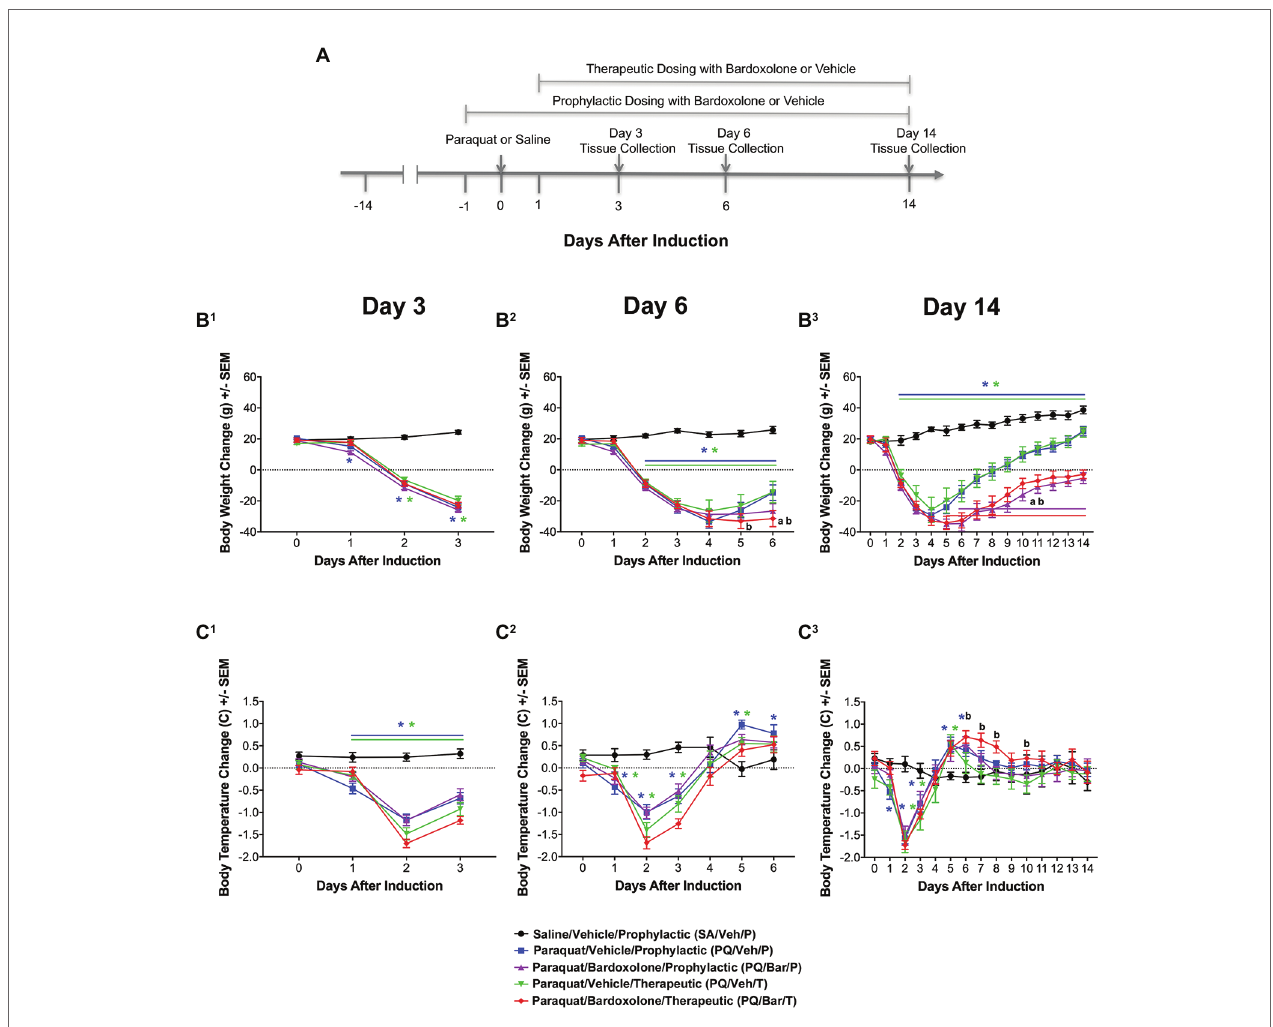
FIGURE 1 | Standard in-life measurements confirmed lung injury and detected effects of bardoxolone treatment in a rodent model of paraquat (PQ)-induced lung injury (PQiLI). (A) Experimental timeline. After a 14-day acclimation period, rats were given an intra-tracheal dose of PQ on Day 0. Rats were orally treated with bardoxolone or vehicle either prophylactically starting the day before PQ administration (Day 1) or therapeutically starting the day after PQ administration (Day 1) daily until study end. Treatment schedules are shown in brackets. Three separate subgroups of rats per study group were euthanized on either Days 3, 6, or 14 for endpoint tissue collection. Automated breathing rate and body motion readouts were collected continuously throughout the study, and standard in-life measurements (body weight and body temperature) were collected daily during the study. (B) Change in body weight. Compared with control rats (SA/Veh/P), body weight was decreased in PQ/Veh/P and PQ/Veh/T rats. These changes were observed as early as Day 1 and as late as Day 14. Bardoxolone-treated rats (PQ/Bar/P and PQ/ Bar/T) showed lower body weights compared with vehicle-treated counterparts. * p ≤ 0.05 vs. SA/Veh/P. a p ≤ 0.01 PQ/Veh/P vs. PQ/Bar/P, and b p ≤ 0.01 PQ/Veh/T vs. PQ/Bar/T. (C) Change in body temperature. Compared with SA/Veh/P rats, body temperature was decreased in PQ/Veh/P and PQ/Veh/T rats as early as Day 1 and as late as Day 3. Despite showing an earlier decrease in body temperature, PQ/Bar/T rats demonstrated higher body temperatures on Days 6–8 and Day 10. (B 1 ,C 1 ) Day 3 ( n = 24 rats for all study groups except n = 23 for SA/Veh/P). (B 2 ,C 2 ) Day 6 ( n = 16 rats for all study groups). (B 3 ,C 3 ) Day 14 ( n = 8 rats for all study groups except n = 7 for SA/Veh/P). * p ≤ 0.05 vs. SA/Veh/P. a p ≤ 0.05 PQ/Veh/P vs. PQ/Bar/P and b p ≤ 0.05 PQ/Veh/T vs. PQ/Bar/T. Error bars are +/ −